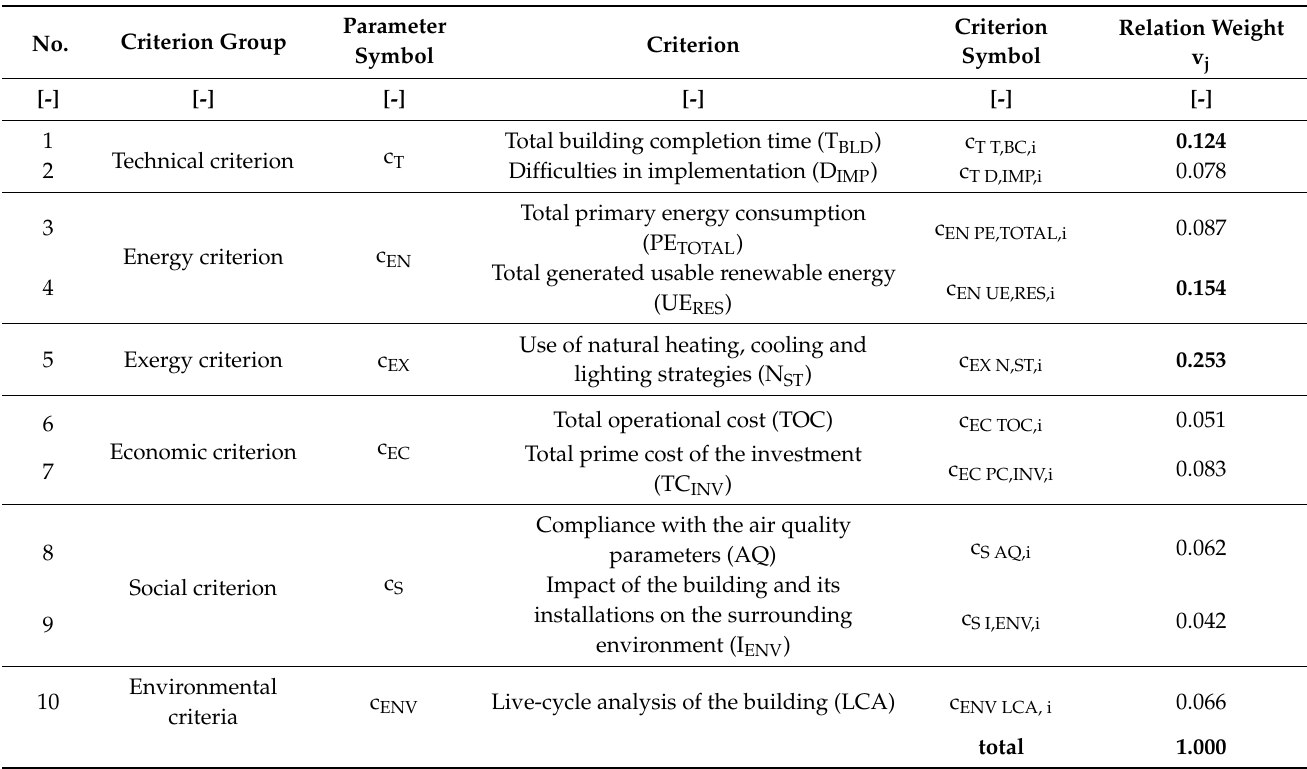
Table 3. Selected decision criteria for selecting new headquarters for the Forest Experimental Station with a positive energy balance and the weights of